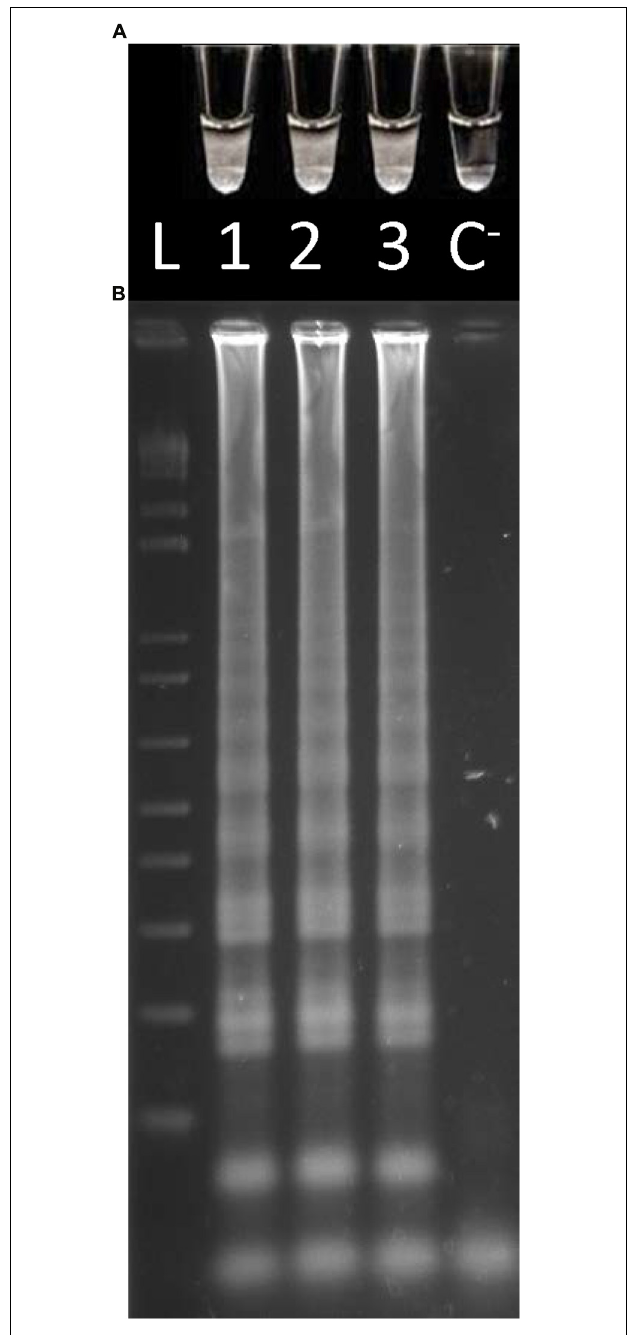
FIGURE 1 | LAMP amplifications from the O. oeni cell suspensions from the culture medium and DNA. (A) Direct turbidity observation; (B) Agarose gel electrophoresis of the amplified products. 1, 2, culture medium; 3, DNA; 4, C − , negative control; L, 1 kb plus DNA Ladder